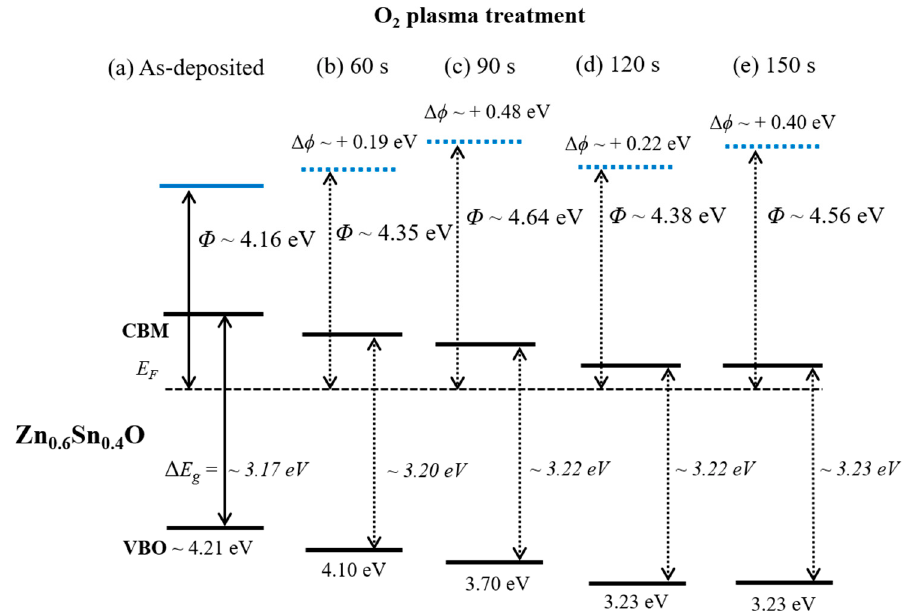
Figure 3. Schematic of modified Zn 0.6 Sn 0.4 O band alignment including work functions and band gaps of all of the O 2 plasma treated materials.